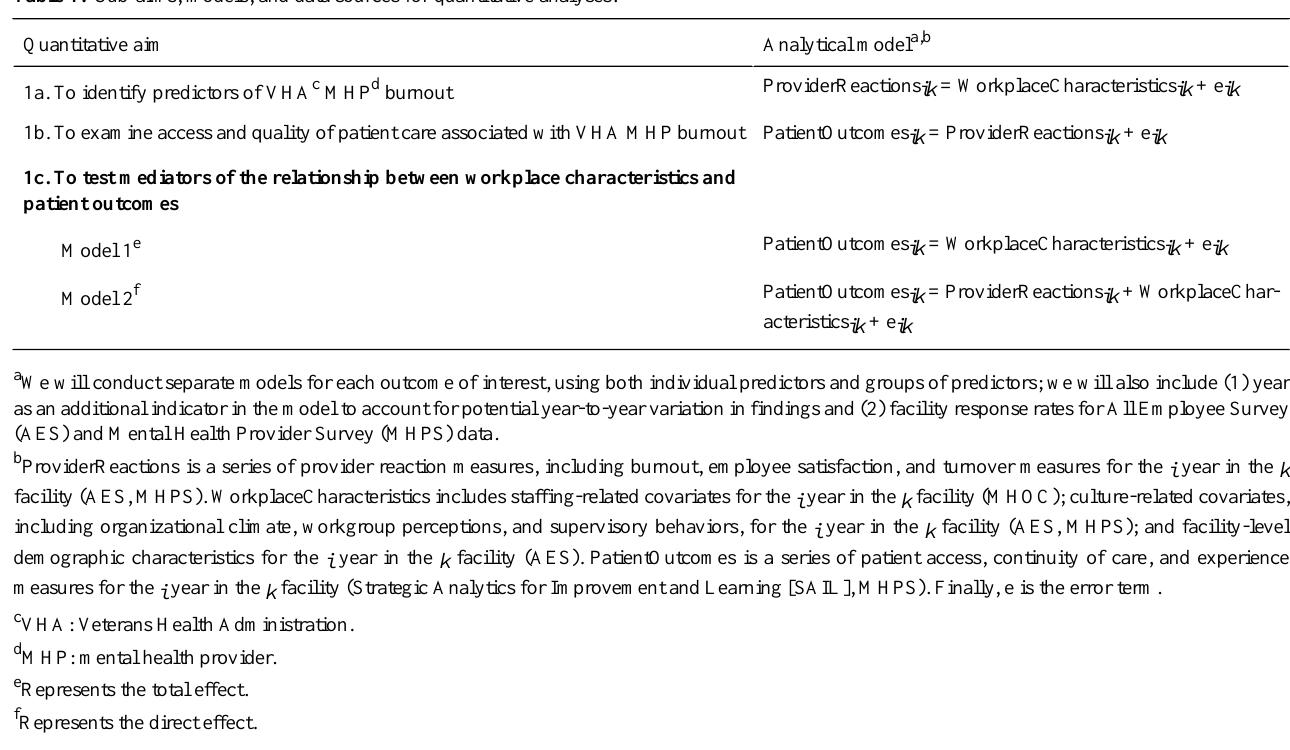
Table 1. Sub-aims, models, and data sources for quantitative analyses.